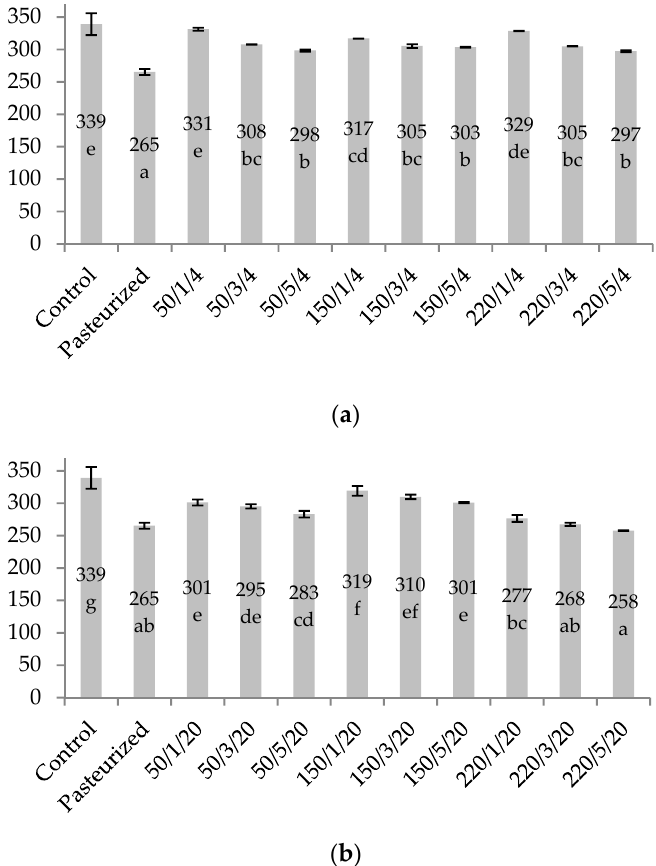
Figure 2. The total concentration of anthocyanins (mg/100 mL) determined in cloudy blackcurrant juice treated with high-pressure homogenization or pasteurization. Samples were labelled as level of pressure/number of passes/inlet temperature. ( a ) HPH samples with the inlet temperature of 4 °C and ( b ) HPH samples with the inlet temperature of 20 °C. The values with different superscript letters (a–g) are significantly different ( p < 0.05). Statistics were performed separately for ( a ) and ( b ).